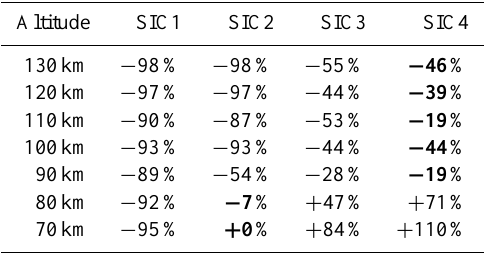
Table 4. As Table 3, but between 6 and 9 September 2005 (Case